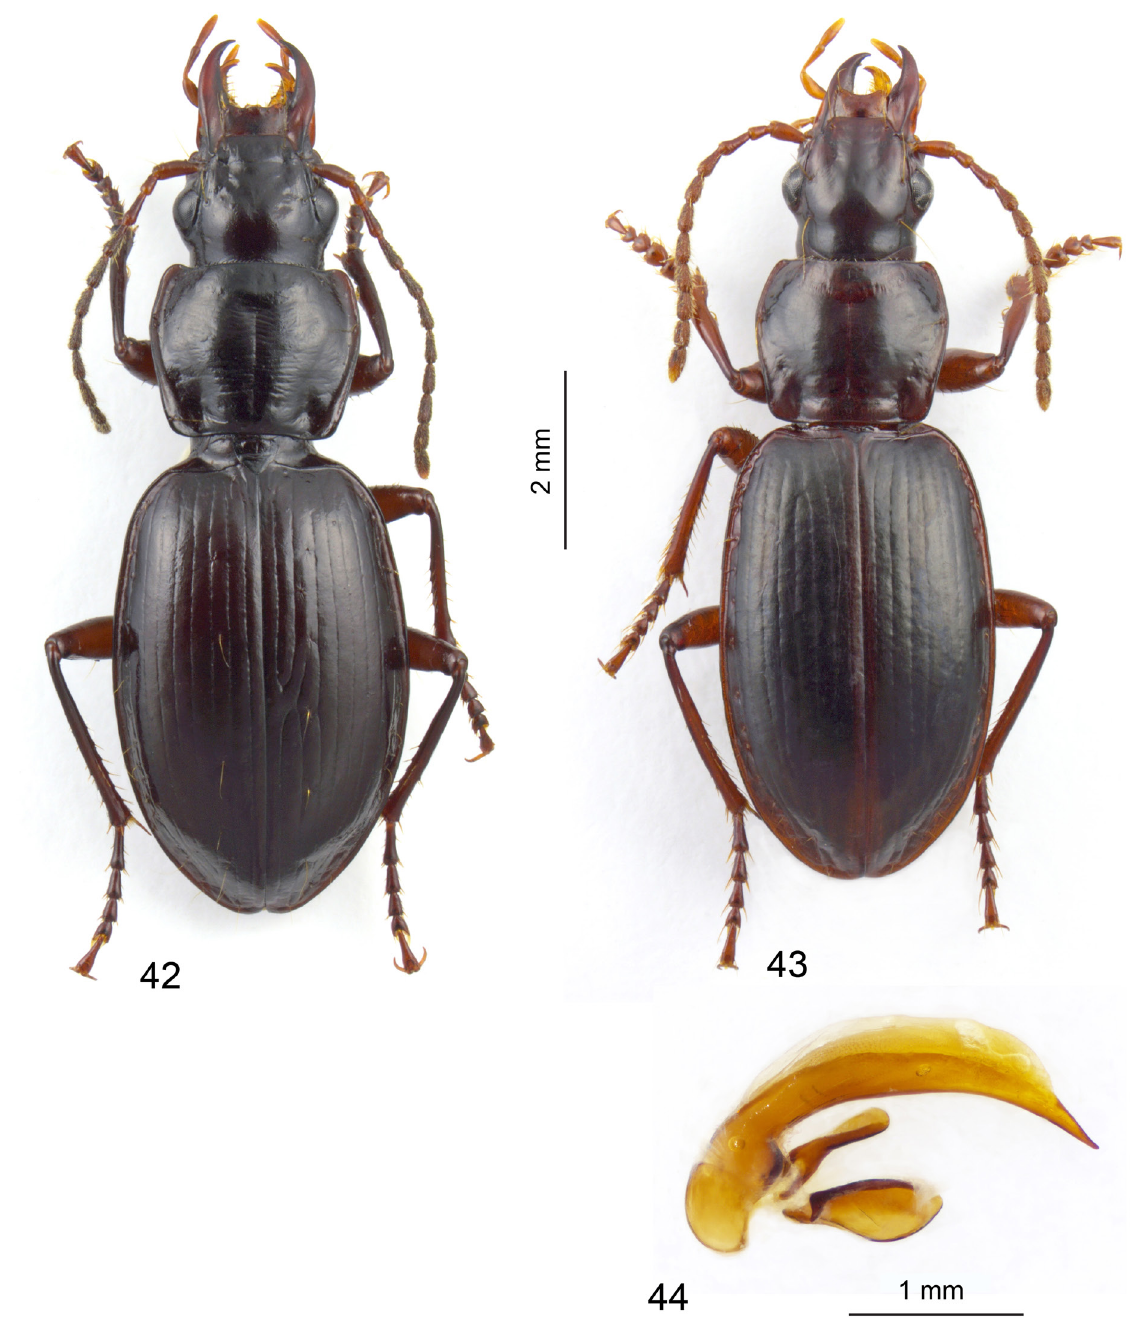
Figs 42–44. 42 . Dyscolus gobbii Moret sp. nov., habitus of the female holotype (QACZ, COI voucher PM210-16). 43–44 . D. barragani Moret sp. nov. 43 . Habitus of the male paratype (CPM, COI voucher PM417-02). 44 . Aedeagus, median lobe in lateral